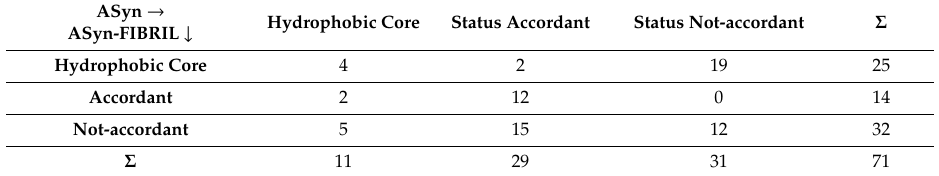
Figure 3. 3D structure presentation; ( A ) 30–100 in form of micelle-bound (profile on Figure 2A); ( B ) Asyn in fibrilar form—residue distribution according to the criterion resulting from the structure micelle-bound (Figure 2A.); ( C ) Asyn in fibrilar form—residues distinguished according to the distribution shown in Figure 2B; C—Asyn micelle-bound with residues distinguished according to profiles as shown in Figure 2B.; Marked: Red residues—hydrophobic core, blue—low values according to the model; white fragment—segment 1–30 not included in amyloid fibril. The yellow fragments visualize the position of those distinguished in Figure 2 as a significantly discordant level of observed hydrophobicity in respect to the expected one. Table 2. Status (number) of residues involved in the construction of the hydrophobic core, showing the status in accordance with the fuzzy oil drop model And incompatible with the fuzzy oil drop model. The columns express the status in micelle-bound ASyn, the rows express the chain treated as a component of fibril.